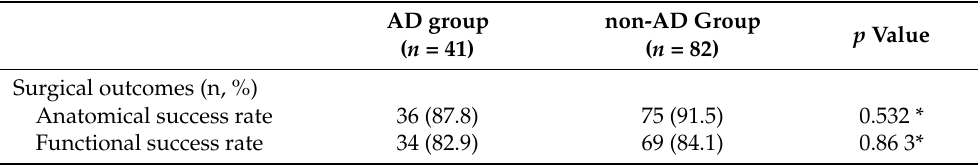
Table 2. Surgical outcomes of